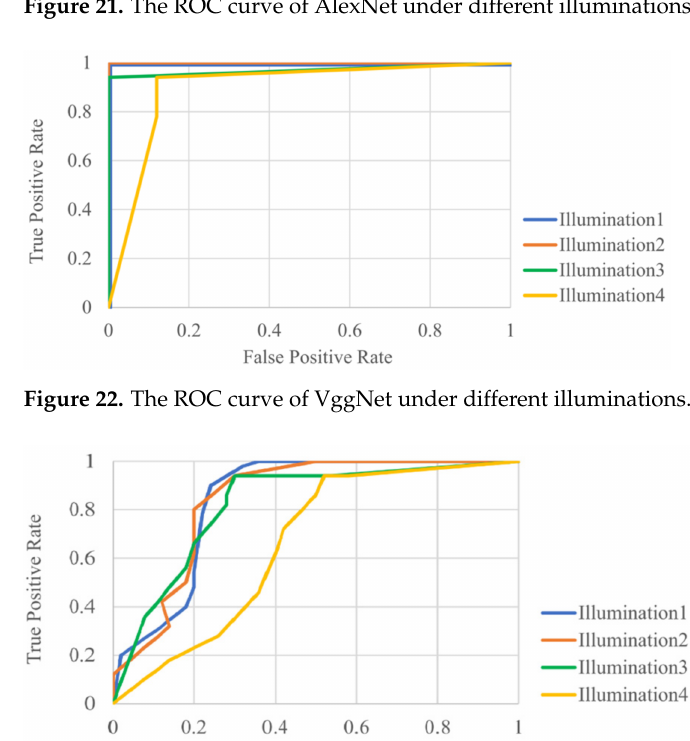
Figure 21. The ROC curve of AlexNet under different illuminations.